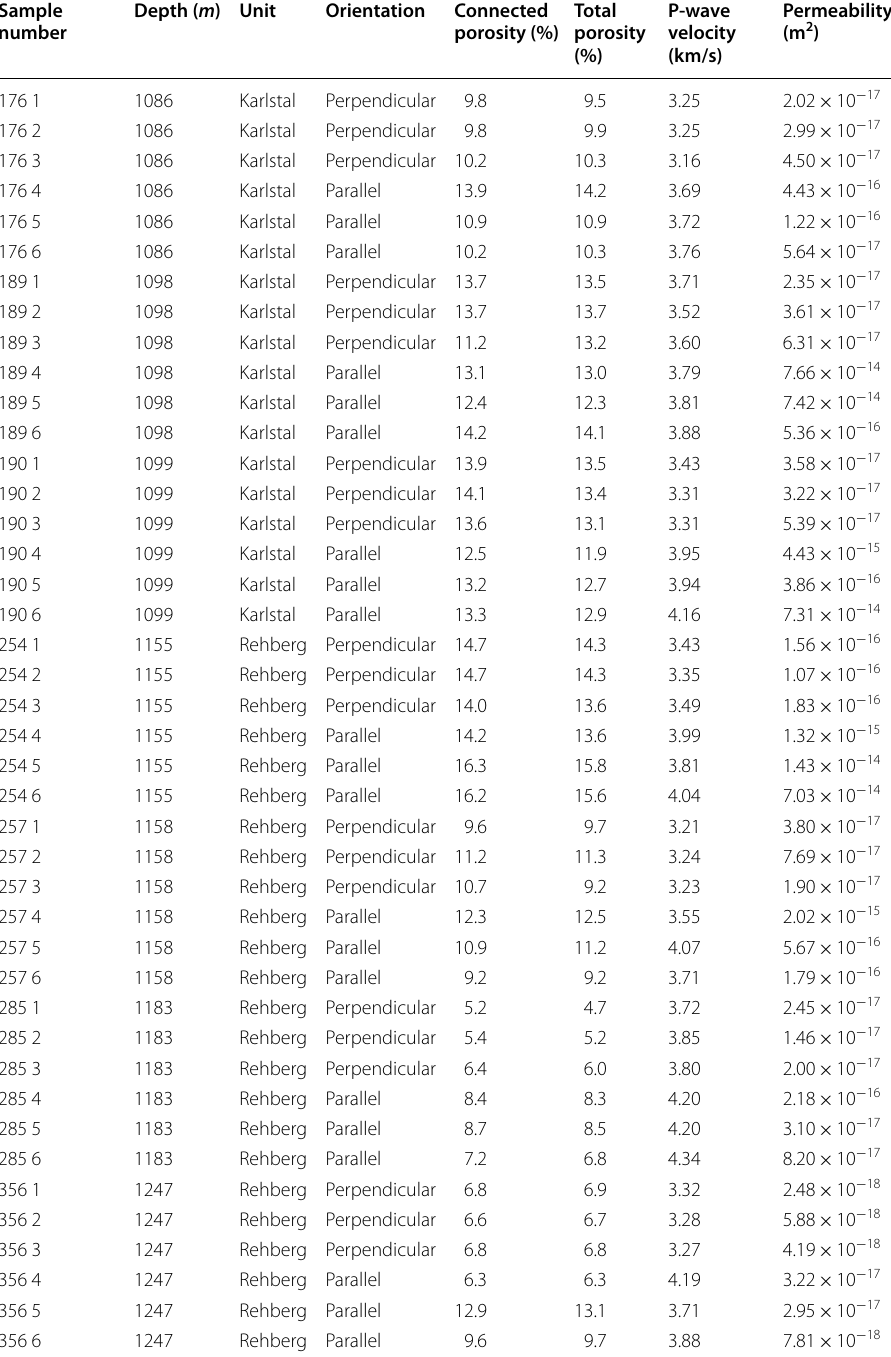
Table 1 Depth, lithostratigraphic unit, sample orientation, connected porosity, total porosity, P-wave velocity, and permeability for each of the 42 Buntsandstein samples prepared for this study Sample